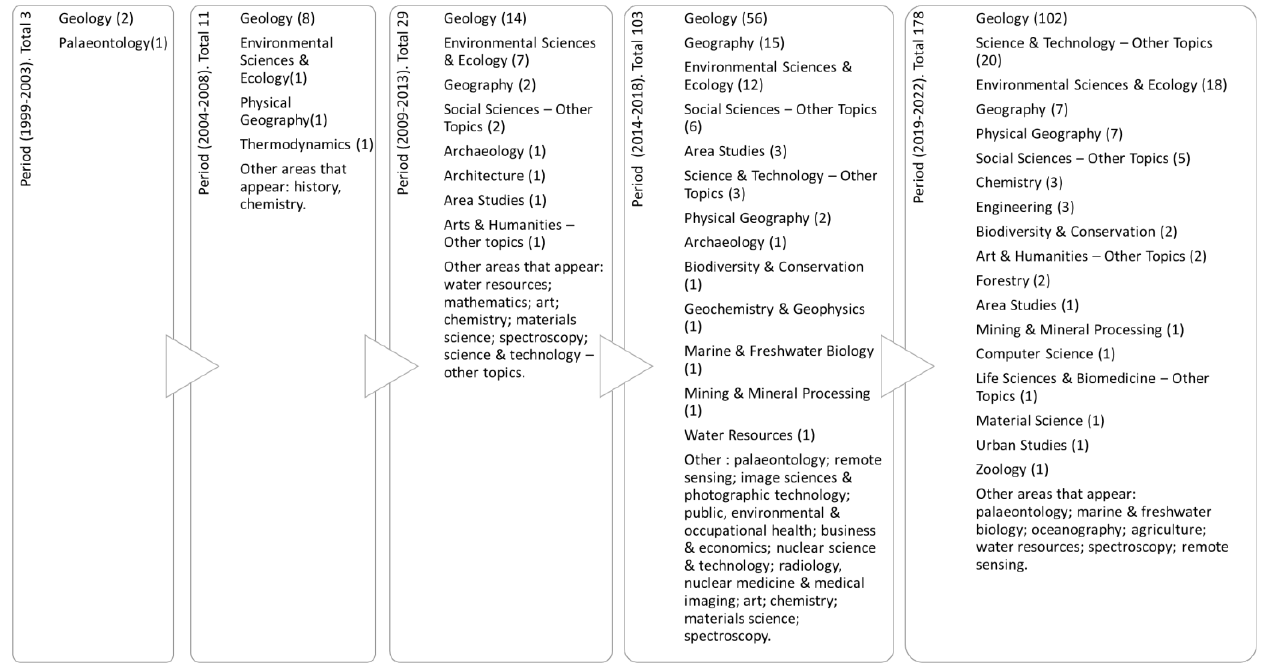
Figure 5. Evolution of research areas.